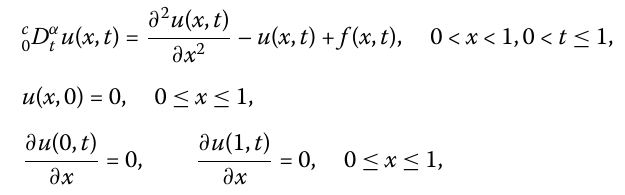
simultaneously. The numerical solution and the global error at T = 1 with α = 0.7, h = 1/32, τ = 1/32 are shown in Fig.